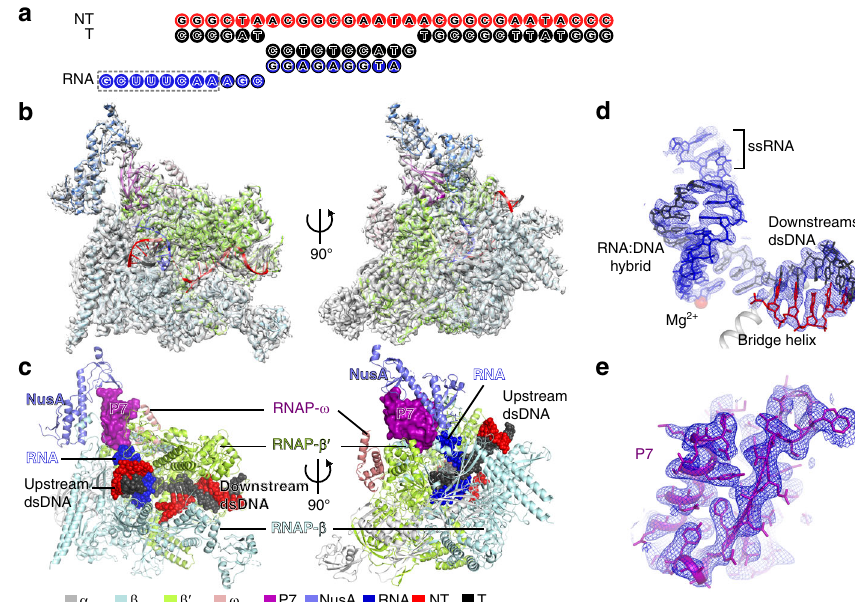
Fig. 1 The overall structure of P7-NusA-TEC. a The scaffold used for obtaining the cryo-EM structures. Nucleotides in dashed box are disordered in the structure. b The map and model of P7-NusA-TEC in top and side views. The cryo-EM electron density map was shown as gray surface. c The overall structure of P7-NusA-TEC in top and side views. d The map and model show unambiguous density for 3-nt ssRNA in the RNA-exit channel and for RNA – DNA hybrid in a post-translocation state. Mg 2 + represents the catalytic magnesium ion at the active center. e The map and model for P7. The cryo- EM electron density map was shown as blue